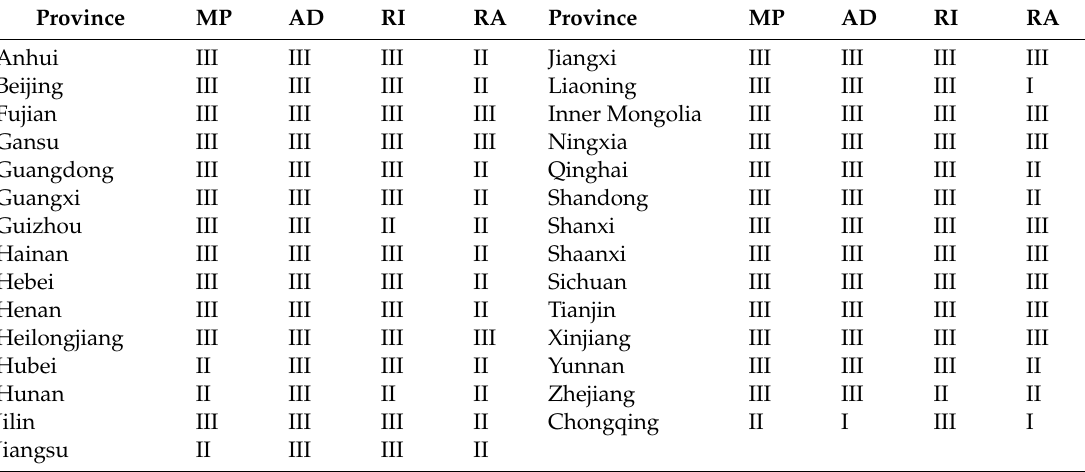
Table 7. Improvement for each